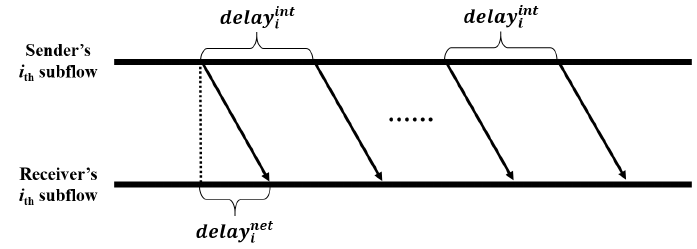
Figure 6. Periodical transmissions of control packet in the UDP